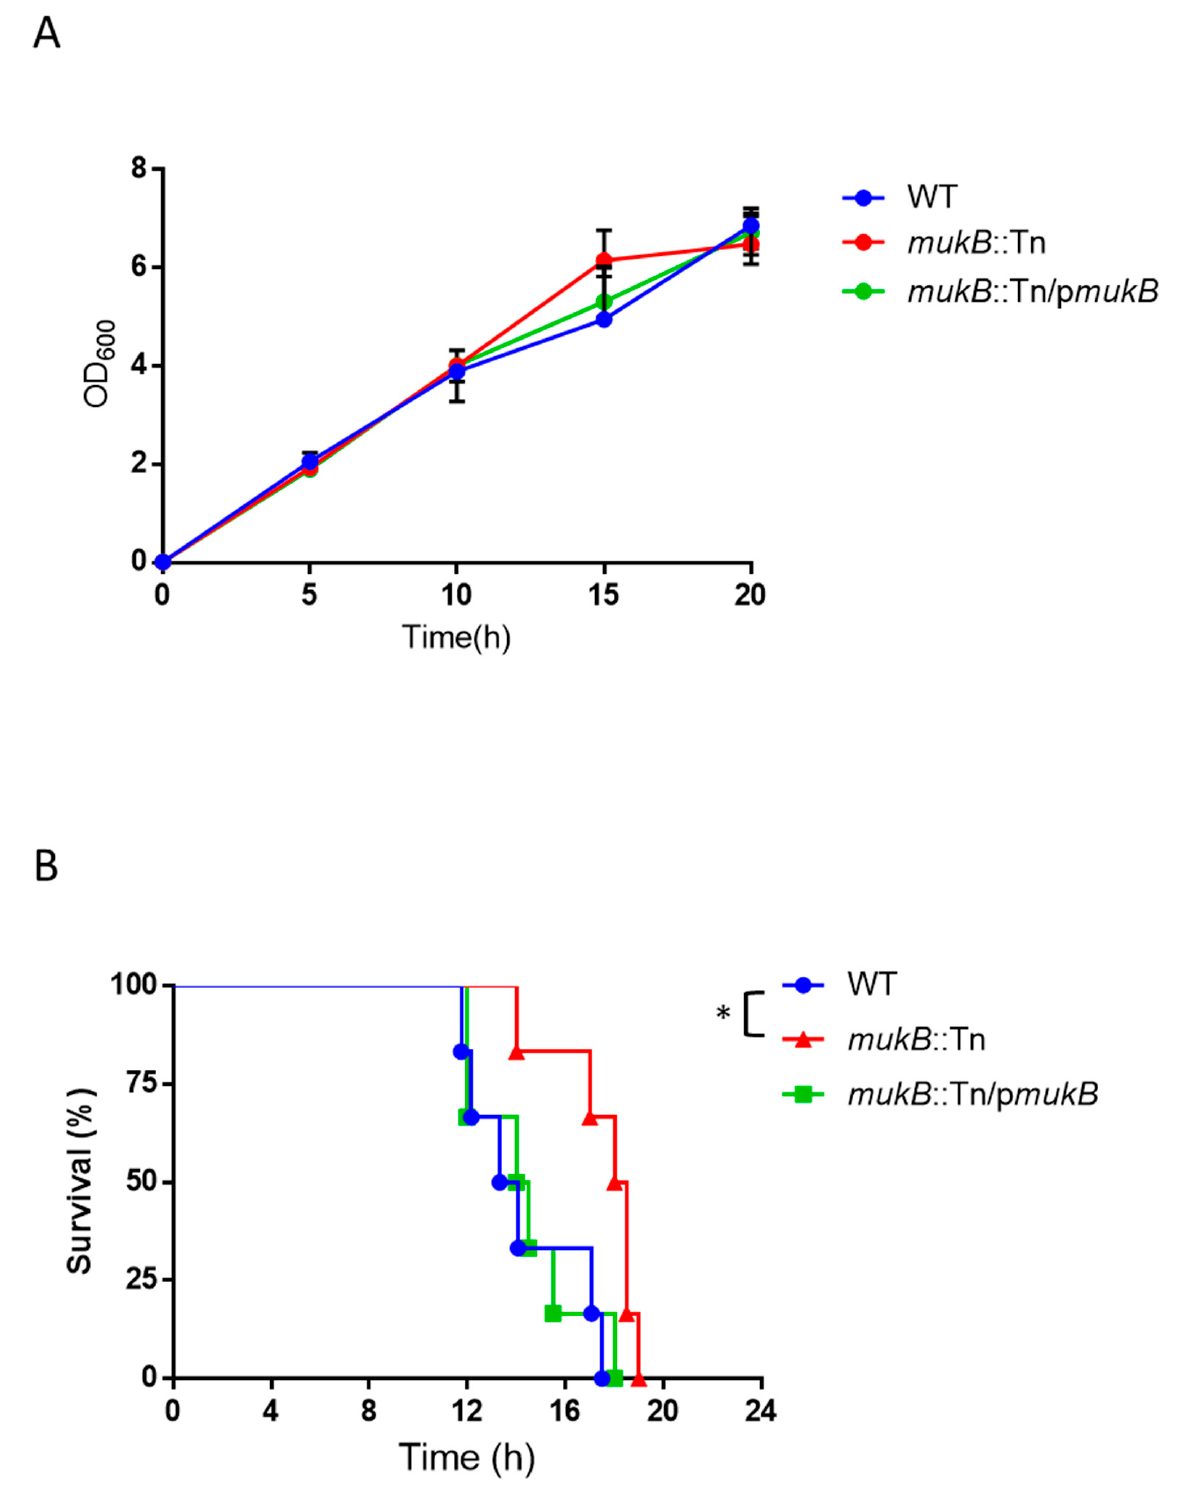
Figure 2. Growth of V. vulnificus and survival of mice. ( A ) In vitro growth of V. vulnificus WT, mukB ::Tn, and mukB ::Tn/p mukB . The starting optical density at 600 nm (OD 600 ) of the cultures was adjusted around 0.01. OD 600 was measured every 5 h. ( B ) Survival curve analysis. Kaplan-Meier survival curves for mice inoculated subcutaneously with WT ( n = 6), mukB ::Tn ( n = 6), or mukB ::Tn/p mukB ( n = 6) and monitored for 24 h. Statistical analyses: log-rank test (* p < 0.05).